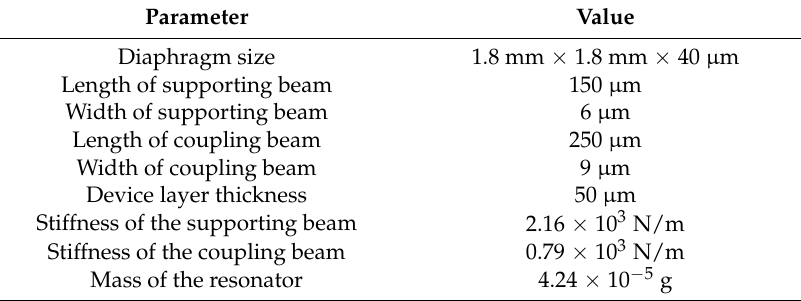
Table 1. The main designed parameters of the sensor